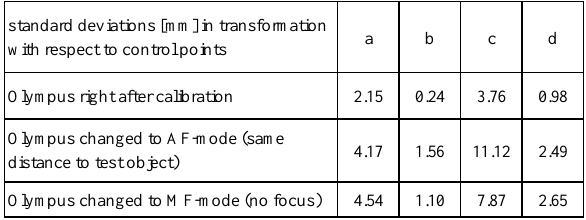
Table 4. Impact of calibration estimation in object space